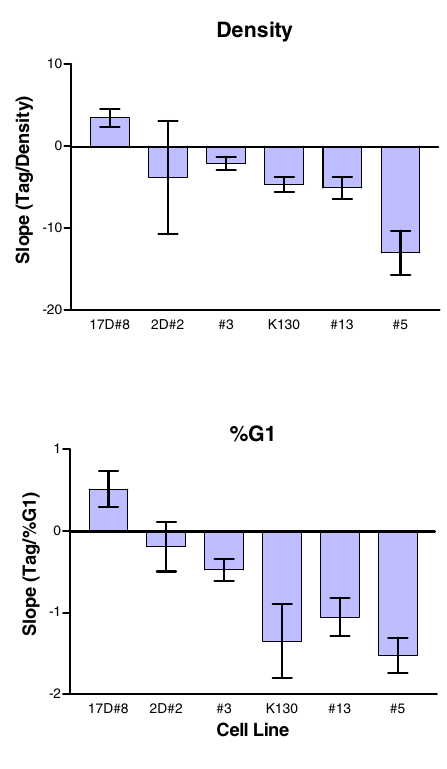
Figure 7 Density related rate of change in Tag expression. Slopes and SE for each cell line determined as shown in Fig- ures 4 and 5 are plotted. All data are significantly different from zero except 2D#2. See Table 1. Cell line names have been abbreviated: #3 = 3DtkT#3, #13 = 13DtkT#13, #5 = 13DtkT#5.